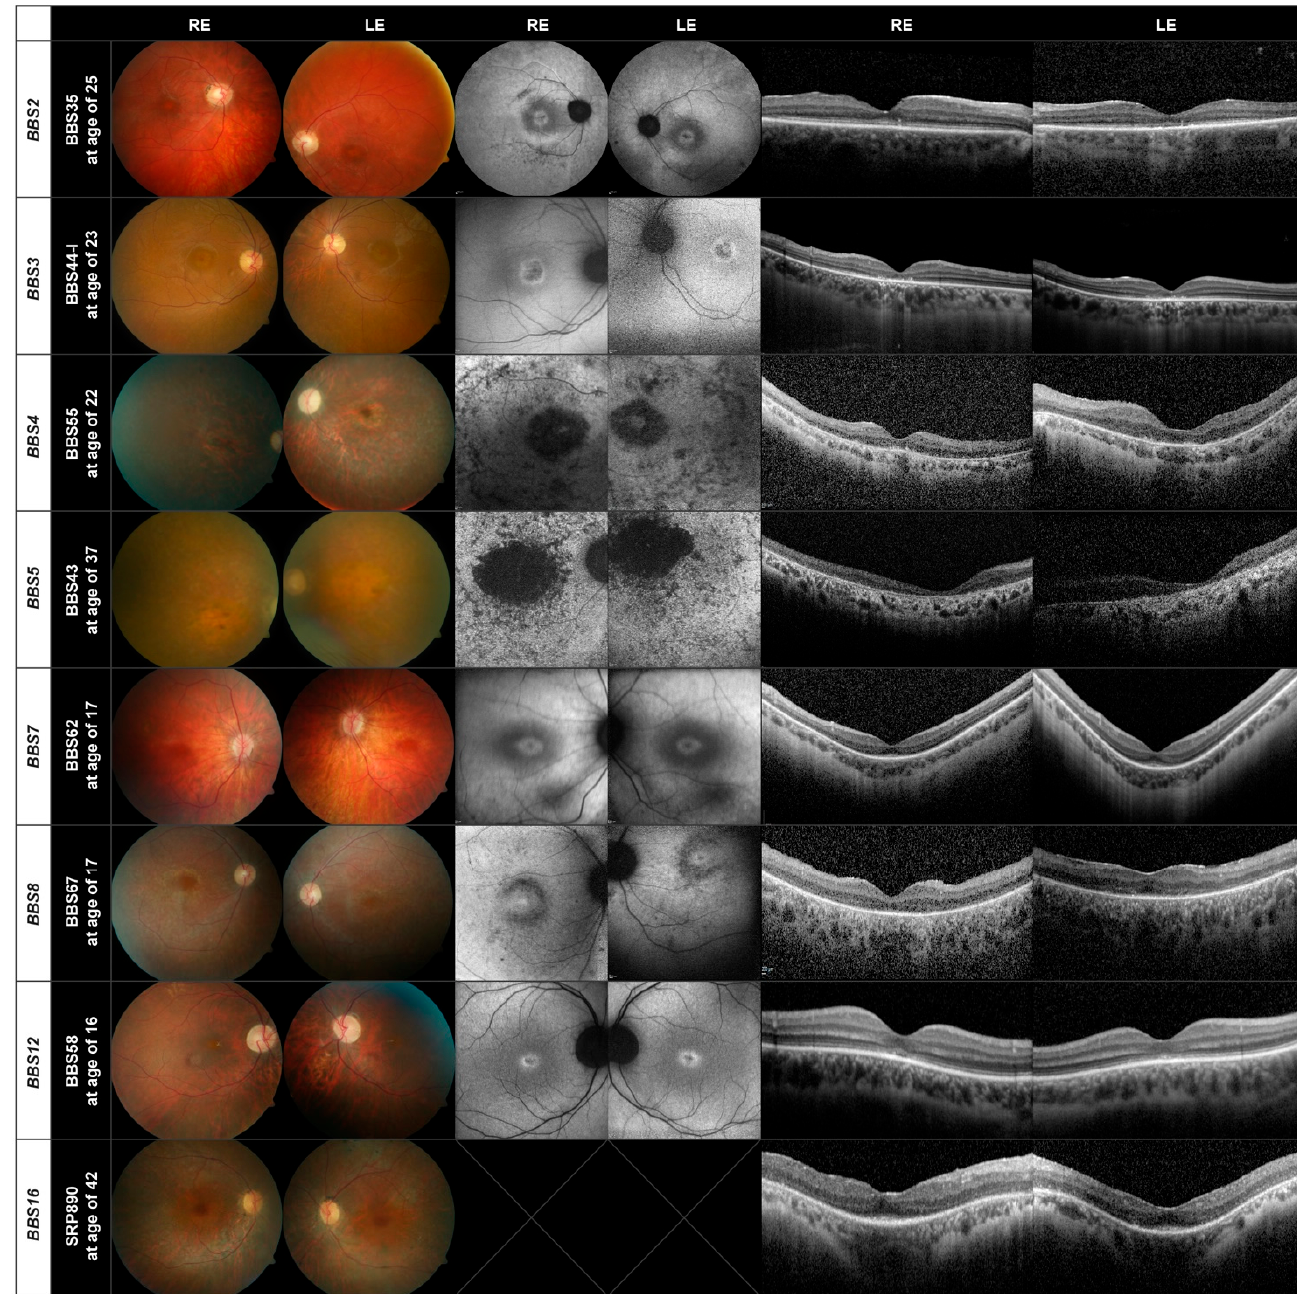
Figure 2. Fundus ( left ), AF ( center ) and OCT ( right ) images of representative patients with disease ‐ causing variants in the BBS1, BBS10, and the BBS9 genes. The images of a normal eye are shown in the first row.